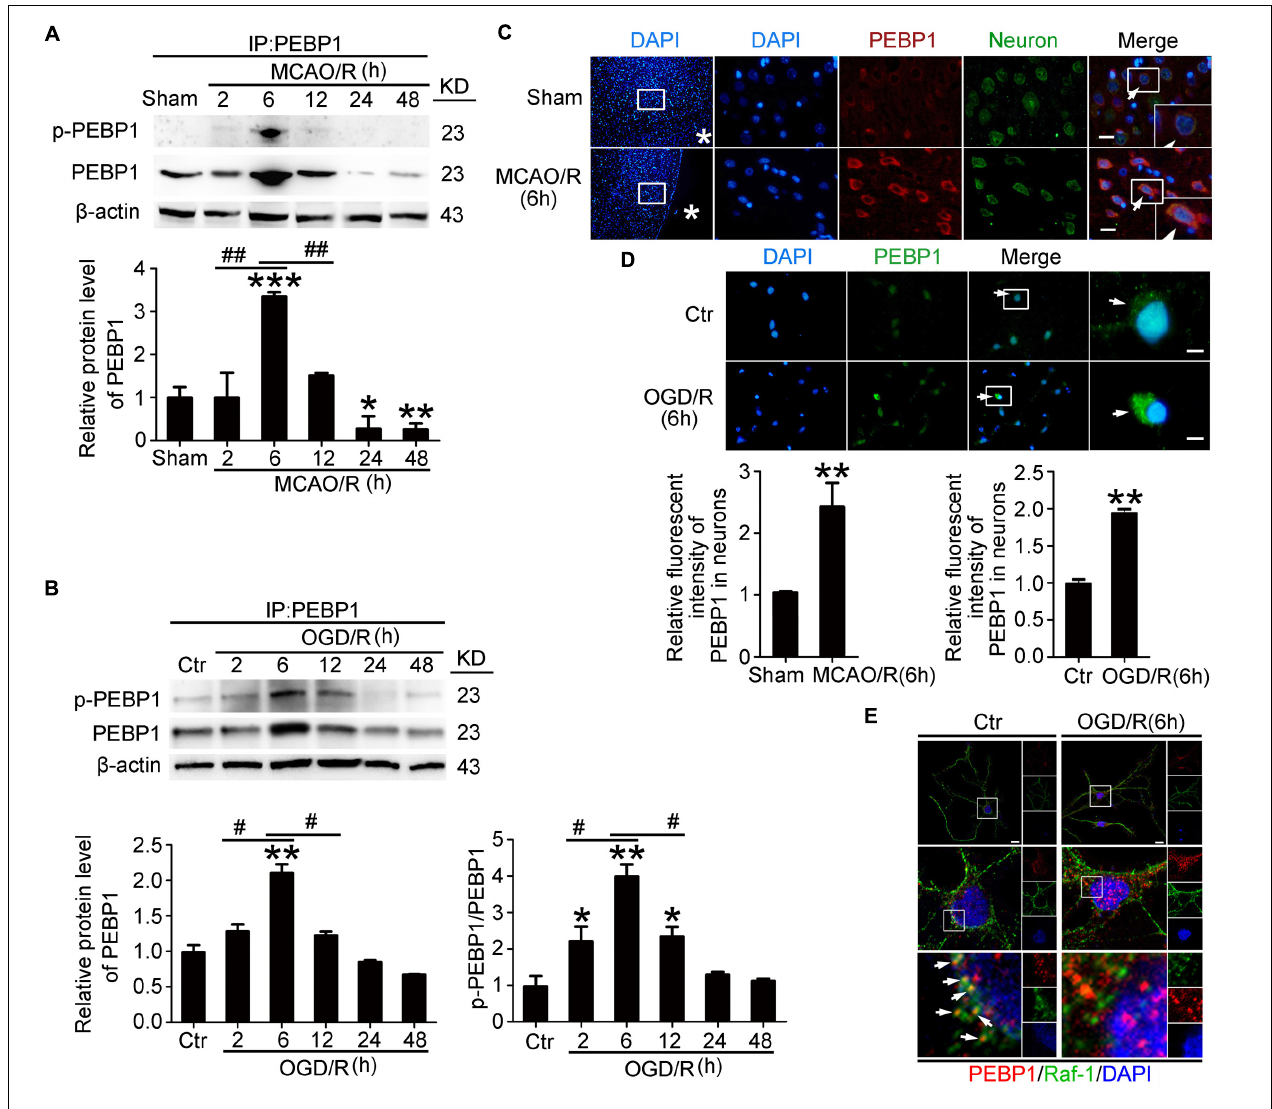
FIGURE 2 | Effects of I/R on the protein level, phosphorylation and the interaction with Raf-1 of PEBP1. In (A,B) , to test the level of p-PEBP1 by western blot easily, immunoprecipitation (IP) using PEBP1 antibody was performed to enrich PEBP1 from total proteins before electrophoresis. (A) Western blot analysis and quantification of the level of PEBP1 and p-PEBP1 in penumbra tissue. ∗ p = 0.0107 vs. sham group, ∗∗ p = 0.0097 vs. sham group, ∗∗∗ p < 0.001 vs. sham group, 2 h group vs. 6 h group ## p = 0.0085, 12 h group vs. 6 h group ## p = 0.0091 ( n = 6/group). (B) Western blot analysis and quantification of the level of PEBP1 and p-PEBP1 in cultured neurons. Phosphorylation levels were evaluated by the ratio of p-PEBP1 to total PEBP1. In PEBP1, ∗∗ p = 0.0089 vs. control group, 2 h group vs. 6 h group # p = 0.023, 12 h group vs. 6 h group # p = 0.013 ( n = 6/group). In p-PEBP1, 2 h group vs. control group ∗ p = 0.0123, 12 h group vs. control group ∗ p = 0.0101, ∗∗ p = 0.0011 vs. control group, 2 h group vs. 6 h group # p = 0.018, 12 h group vs. 6 h group # p = 0.023 ( n = 6/group). (C) Double immunofluorescence analysis was performed with antibodies for PEBP1 (red) and neuron marker (NeuN, green). Nuclei were fluorescently labeled with DAPI (blue). Representative images of the sham and MCAO/R (6 h) groups are shown. Asterisks mark the outside of the brain. Arrows indicate the distribution of PEBP1 in neurons. Scale bar = 20 µ m. The relative fluorescent intensity of PEBP1 in neurons was shown below. ∗∗ p = 0.0091 vs. sham group ( n = 6/group). (D) Immunofluorescence analysis was performed with antibody for PEBP1 (green) in cultured neurons. Nuclei were fluorescently labeled with DAPI (blue). Representative images of control group and OGD/R (6 h) group were shown. Arrows indicate the distribution of PEBP1 in neurons. Scale bar = 20 µ m. The relative fluorescent intensity of PEBP1 in neurons was shown below. ∗∗ p = 0.0085 vs. control group ( n = 6/group). Statistical comparisons between groups were performed using one-way analysis of variance followed by either a Dunnett’s or a Tukey’s post hoc test, the former for comparisons to a single control group, the latter to compare across multiple groups. (E) Double immunofluorescence analysis was performed with antibodies for PEBP1 (red) and Raf-1 (green). Nuclei were fluorescently labeled with DAPI (blue). Representative images of the control and OGD/R (6 h) groups are shown. Arrows indicate the co-localization of PEBP1 and Raf-1 in neurons. Scale bar = 20 µ m. p-PEBP1: phosphorylated PEBP1 at